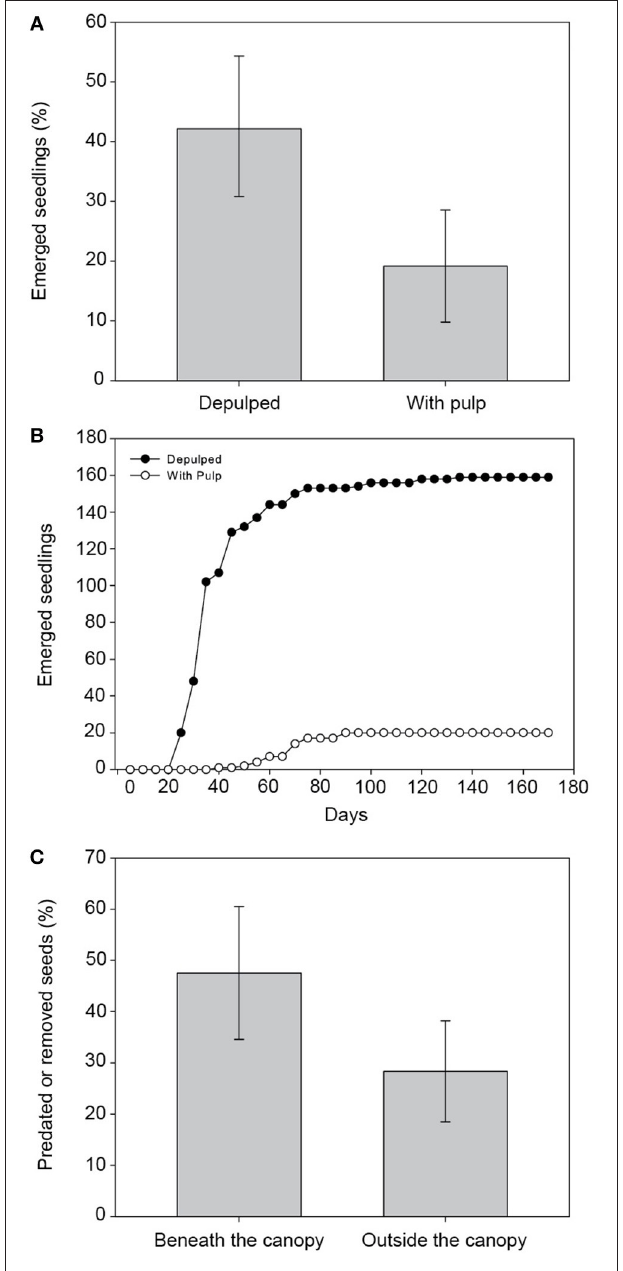
FIGURE 4 | Potential consequences of external seed dispersal for Dracaena draco . Depulped seeds lead to a higher proportion (A) and rate (B) of seedling emergence than seeds contained inside fruits. Also, seed removal (C) is higher beneath the canopy than outside the canopy of parent trees.